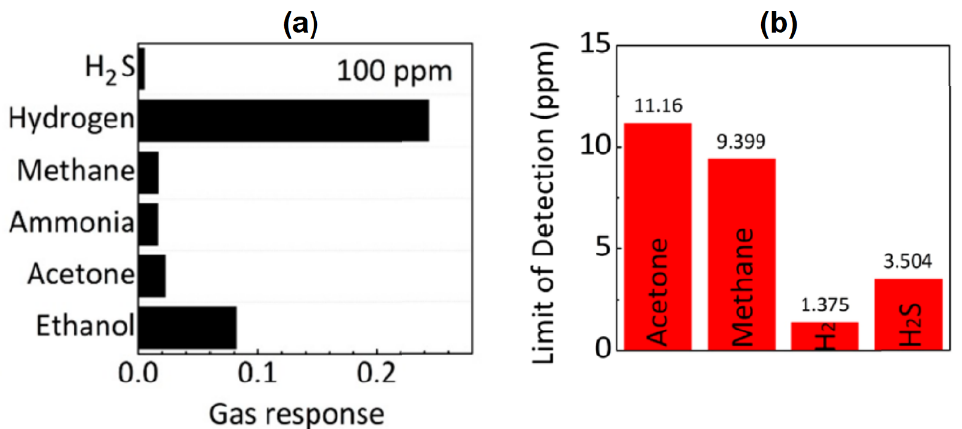
Figure 13. ( a ) Gas sensor response of V 2 CT x to the various gases with a concentration of 100 ppm at room temperature. ( b ) The theoretical detection limit of the V 2 CT x -based sensor to various gases. Adapted with permission from [49]. Copyright © 2019, American Chemical Society.